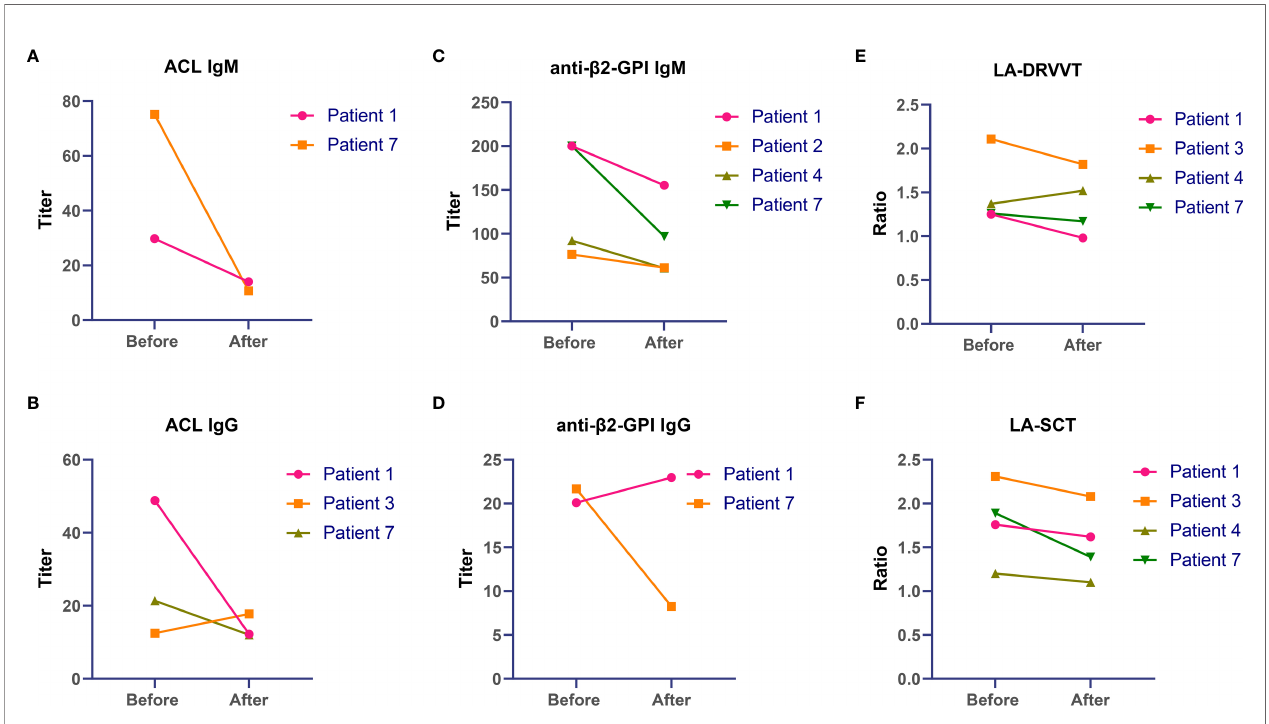
FIGURE 3 | Changes in antiphospholipid antibodies after sirolimus therapy in primary antiphospholipid syndrome patients with thrombocytopenia. (A) ACL IgM, (B) ACL IgG, (C) anti- b 2-GPI IgM, (D) anti- b 2-GPI IgG, (E) LA-DRVVT, (F) LA-SCT. ACL, anticardiolipin; anti- b 2-GPI, anti- b 2-glycoprotein I; LA, lupus